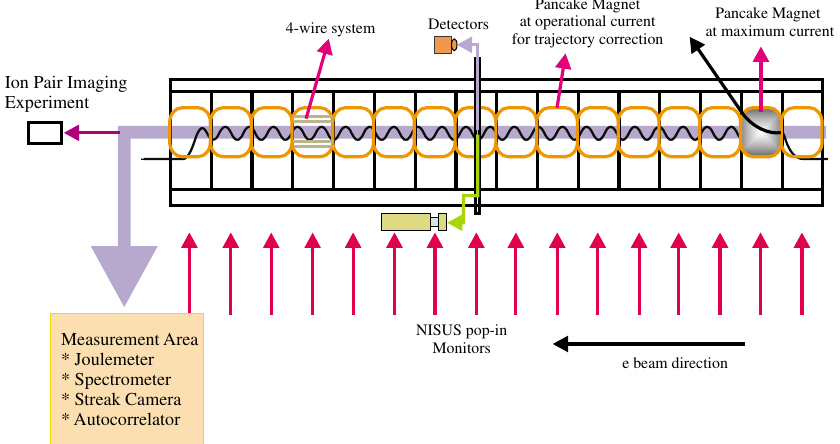
FIG. 2. (Color) 10 m long Nisus wiggler (radiator) and its diagnostics. The four-wire system is used for additional focusing and trajectory correction. The pancake magnet system is used for the horizontal trajectory correction and beam kicking.